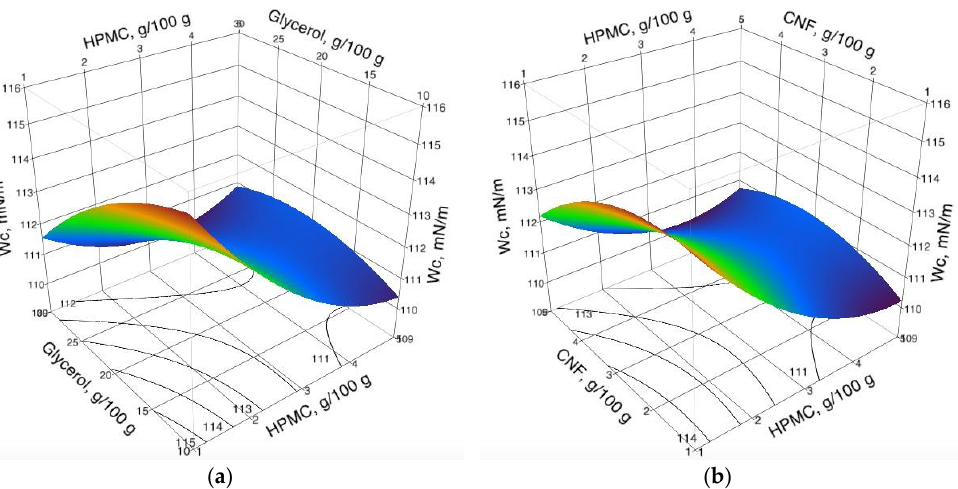
Figure 1. Response surface of W C as a function of ( a ) HPMC and glycerol, ( b ) HPMC and cellulose nanofibers (CNF).